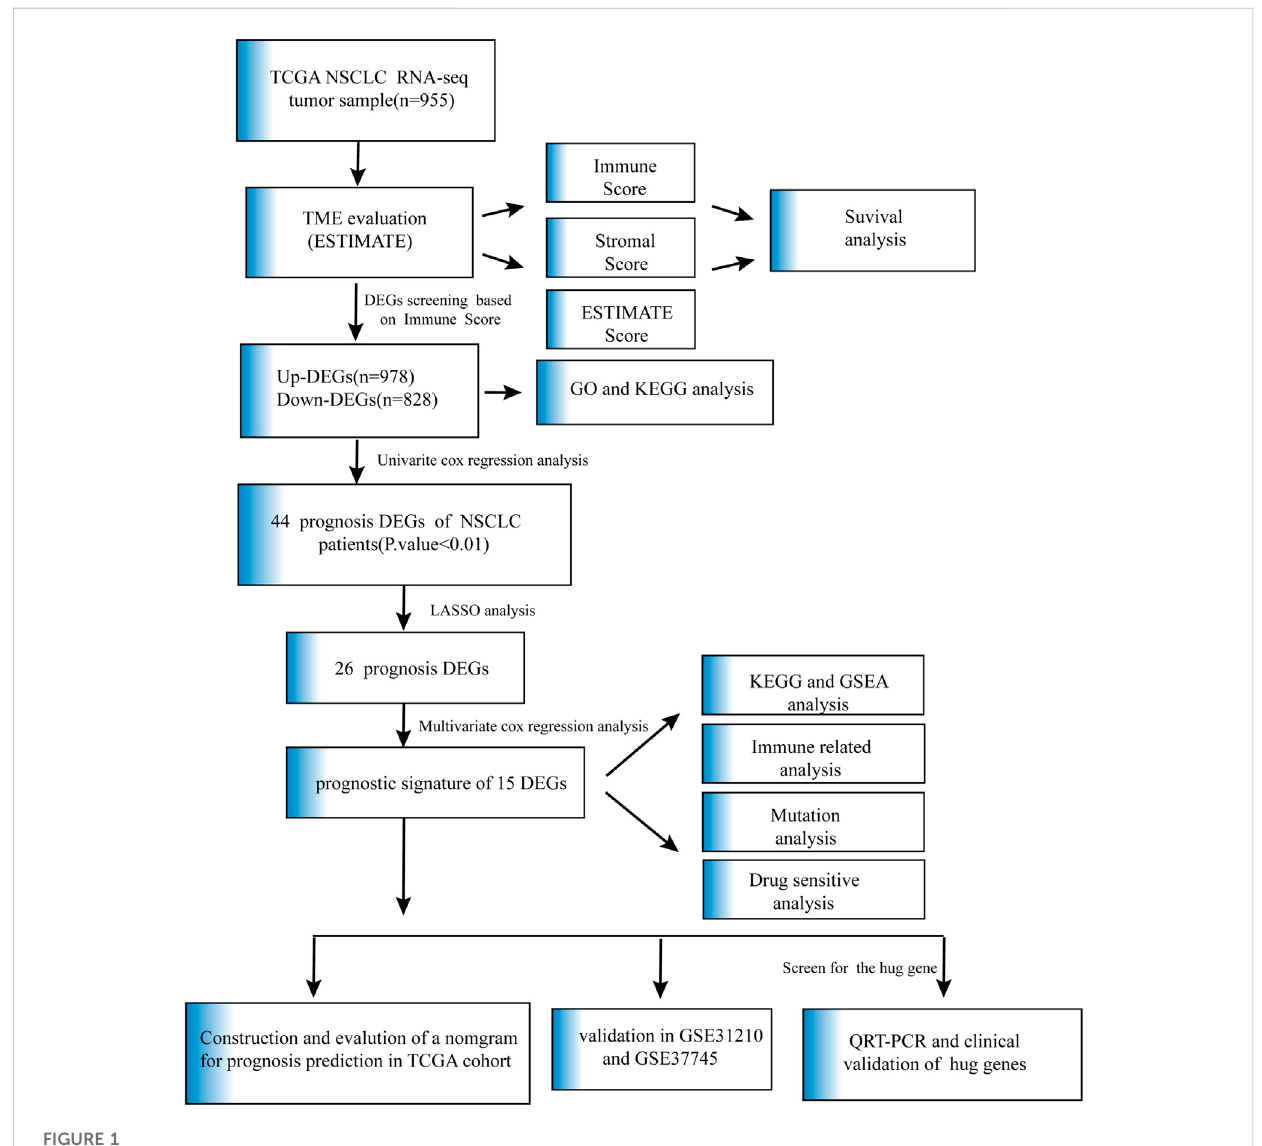
FIGURE 1 Flow chart of data collection and